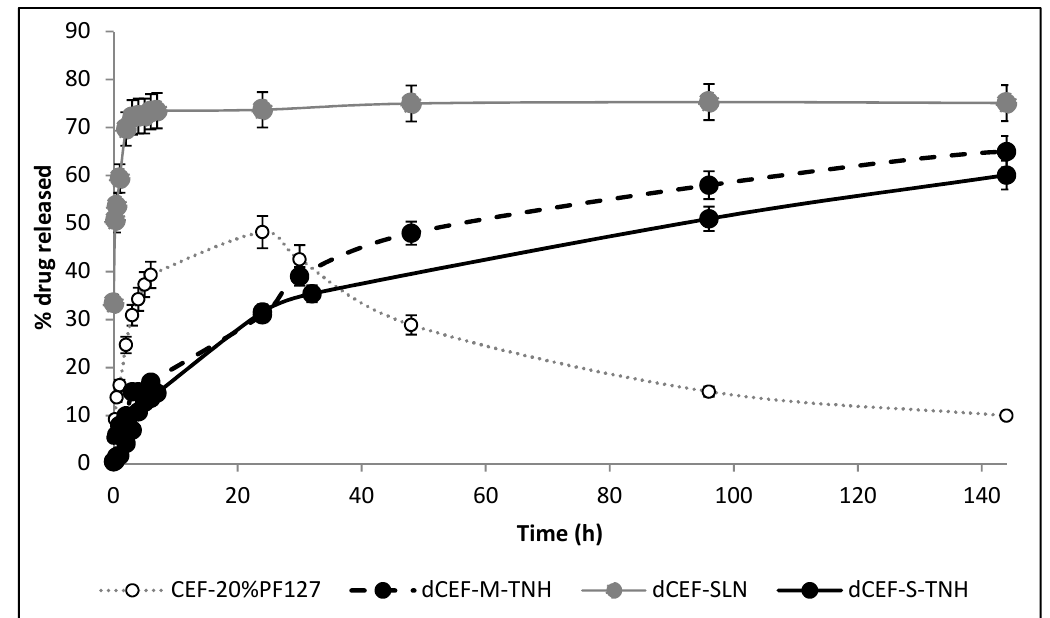
Figure 13. In vitro tube test release of CEF from 20% w/v PF127 hydrogel (grey line) or dCEF from SLN (grey solid line) and from nanocomposite systems: S-TNH (black solid line) and M-TNH (black dotted line). 15% v/v Tween®80 aqueous solution was used as receptor medium. Each bar represents the mean ± SD ( n = 5). Compared to the control (CEF-20%PF127), during the first 24 h drug release from the nanocomposites was significantly reduced ( p < 0.05) meanwhile from the 2nd day to the end